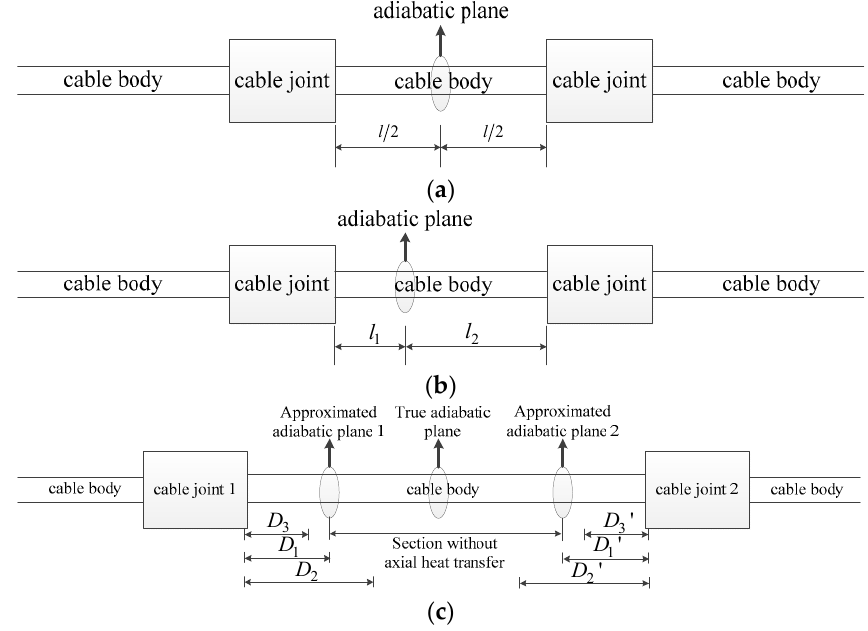
Figure 3. Adiabatic plane of the cable joint: ( a ) adiabatic plane with symmetrical cable stretch, ( b ) adiabatic plane with asymmetrical cable stretch and ( c ) illustration of the method for setting the approximated adiabatic plane.